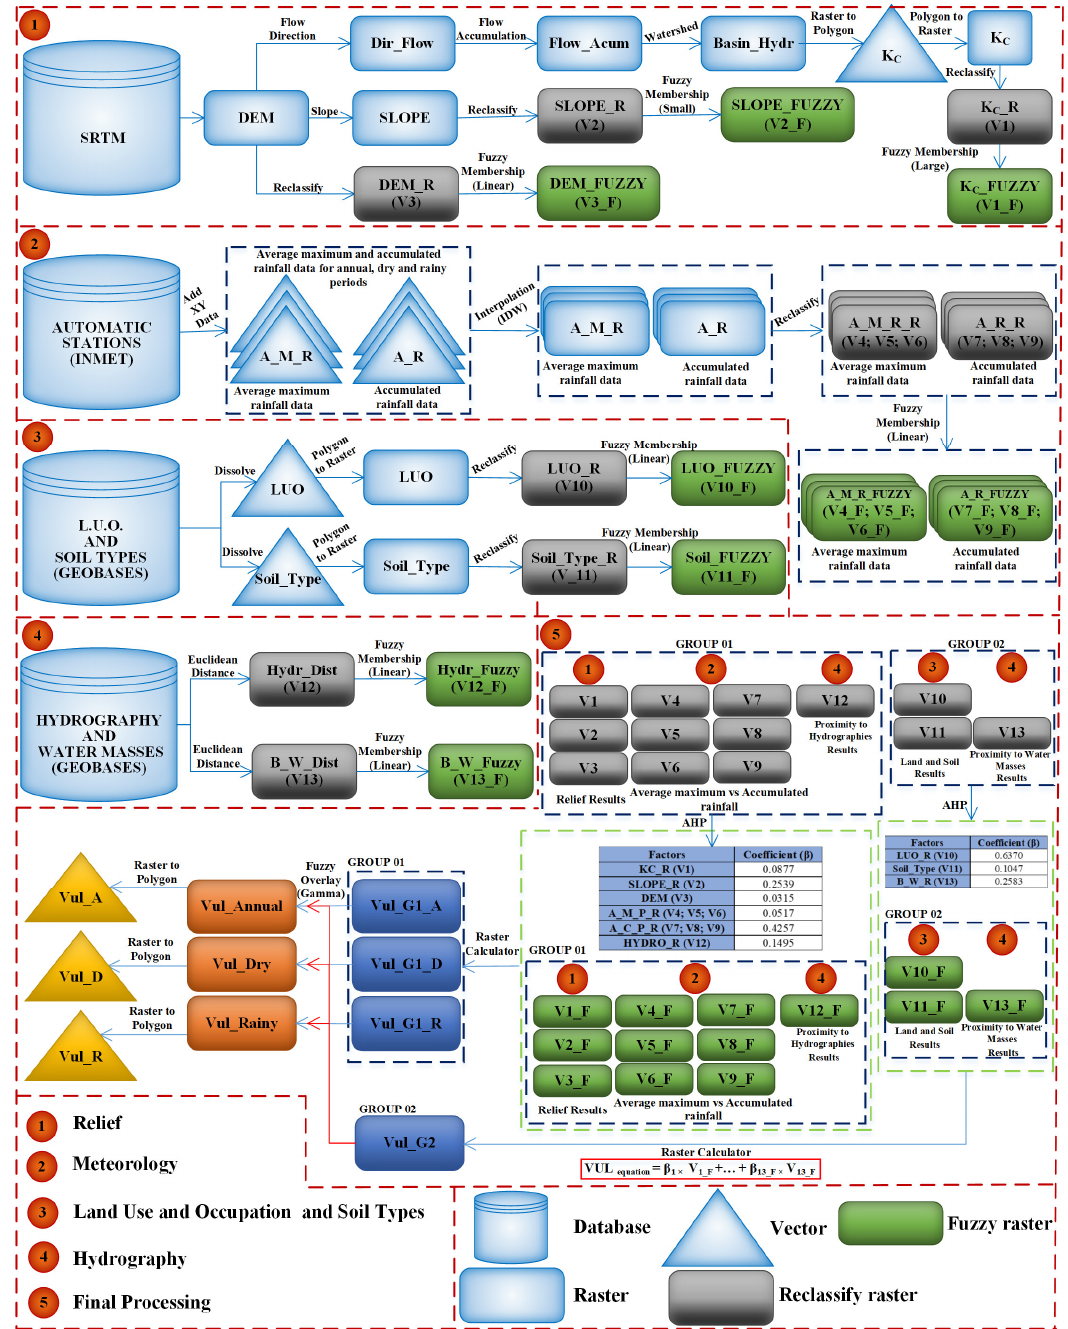
Figure 2. Methodological flowchart containing the necessary steps for the flood vulnerability model development for Espírito Santo state.